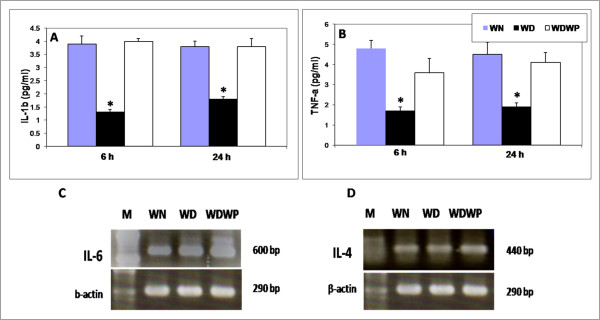
A, B: ELISA estimation of both IL-1β and TNF-α levels at 6 h and 24 h in wounded non-diabetic normal rats (WN), wounded diabetic rats (WD) and wounded diabetic rats supplemented with whey protein (WDWP). C,D: Gene expression of the IL-6 (6 h) and IL-4 (24 h) proteins in the three groups showing a notable effect of the whey protein on both cytokines after wounding.